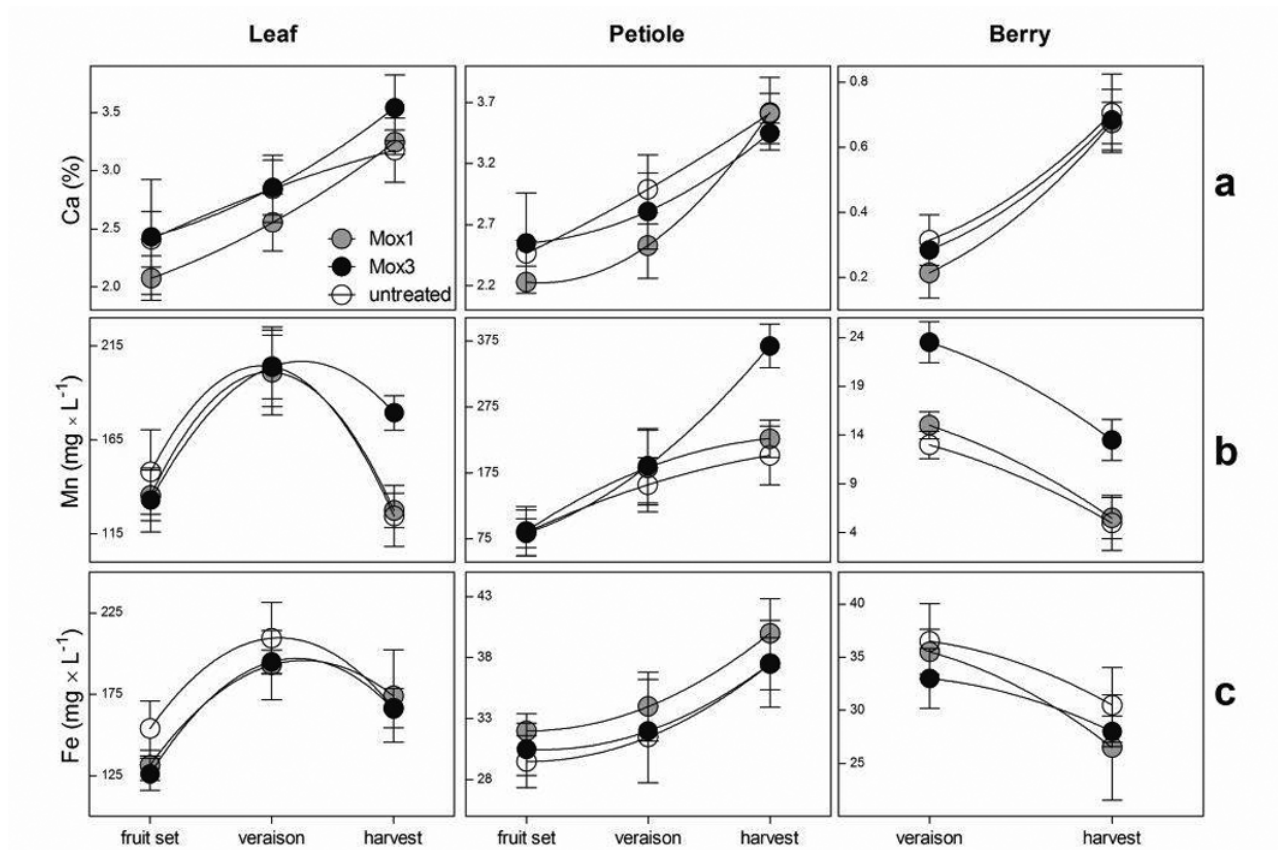
Fig. 2 - Secondary macro (Ca) and micronutrient (Mn, Fe) concentrations in basal leaf, petiole and berry at fruit set, veraison and harvest in Mo- treated and untreated grapevine plants. Error bars reflect the LSD at p ≤ 0.05. Mox1= Mo treatment in early flowering; Mox3= Mo treat- ments in early flowering, early fruit set and early